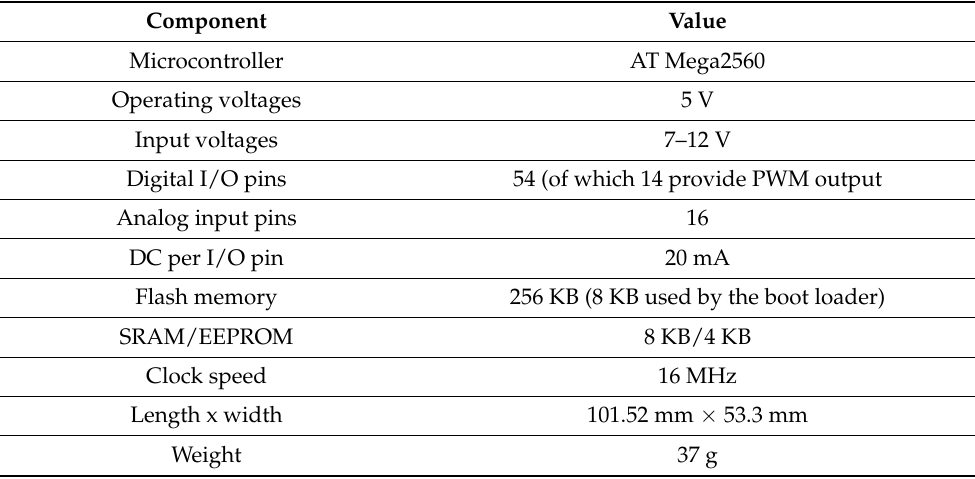
Table 1. Arduino Mega board technical specifications [30].